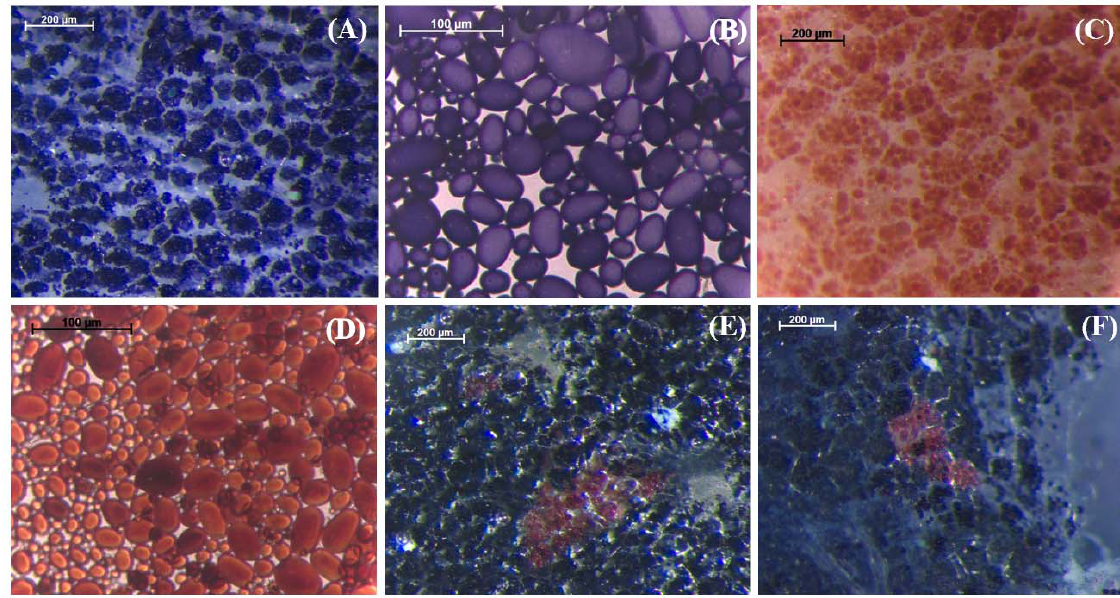
Figure 3. Histochemical Lugol ‐ Iodine staining of sections from tubers produced by soil ‐ grown plants showing different phenotypes. ( A ) wild ‐ type (Yukon Gold, strain TXYG79) tuber section showing typical blue staining of starch indicative of normal amylose:amylopectin ratio; ( B ) stained starch granules from wild ‐ type tuber; ( C ) tuber section from event T2 ‐ 7 wherein Target site 2 was targeted for mutation showing a complete knockout phenotype (i.e., reddish ‐ brown ‐ colored staining due to the absence of amylose); ( D ) stained starch granules from event T2 ‐ 7; ( E ) tuber section from event T1 ‐ 27, wherein Target site 1 was targeted for mutation showing a small sector of complete knockout phenotype surrounded by largely blue ‐ colored tuber section; ( F ) tuber section from event T2 ‐ 2, wherein Target site 2 was targeted for mutation showing a small sector of complete knockout phenotype surrounded by largely blue ‐ colored tuber section.